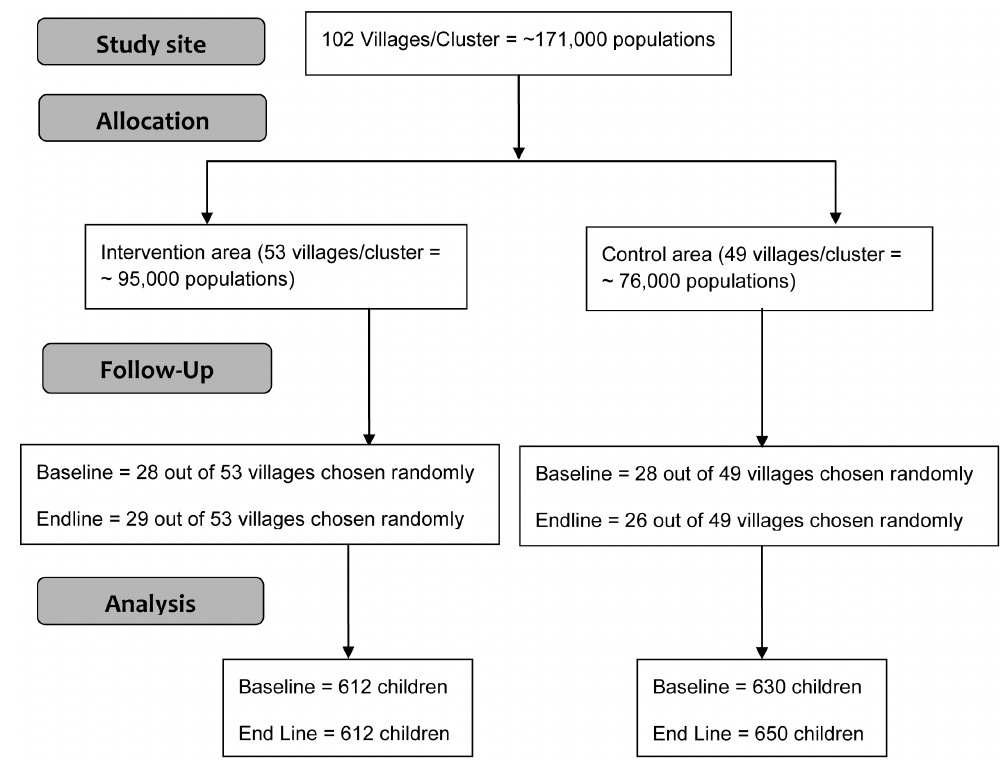
Figure 1. Trial Flowchart.